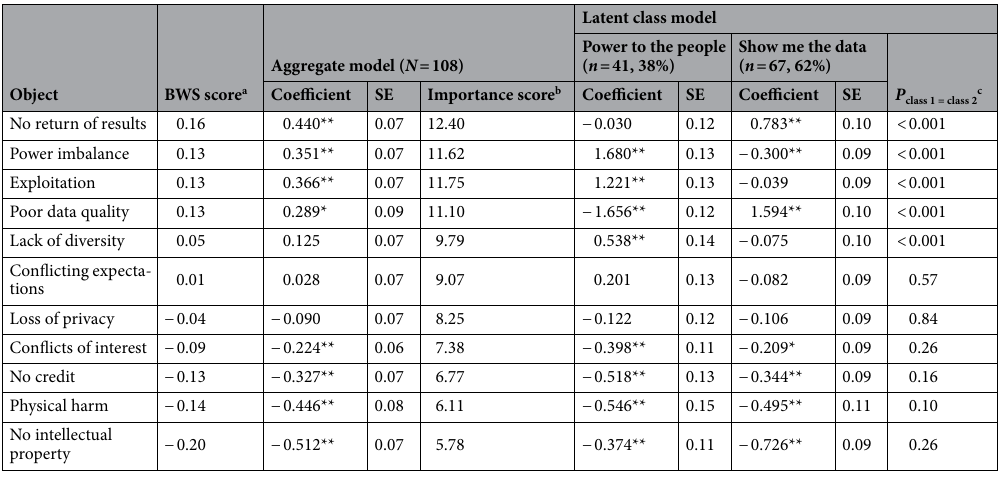
Table 2. BWS scores and aggregate and latent class conditional logit models. a BWS scores calculated by subtracting least-concern count for each object from its most-concern count and dividing by the number of times the object appeared in the survey (5 × N ). b Importance scores calculated by rescaling coefficients from conditional logit on a ratio scale from 0 to 100. c Wald test of overall model differences: P < 0.001. * P ≤ 0.01, ** P ≤